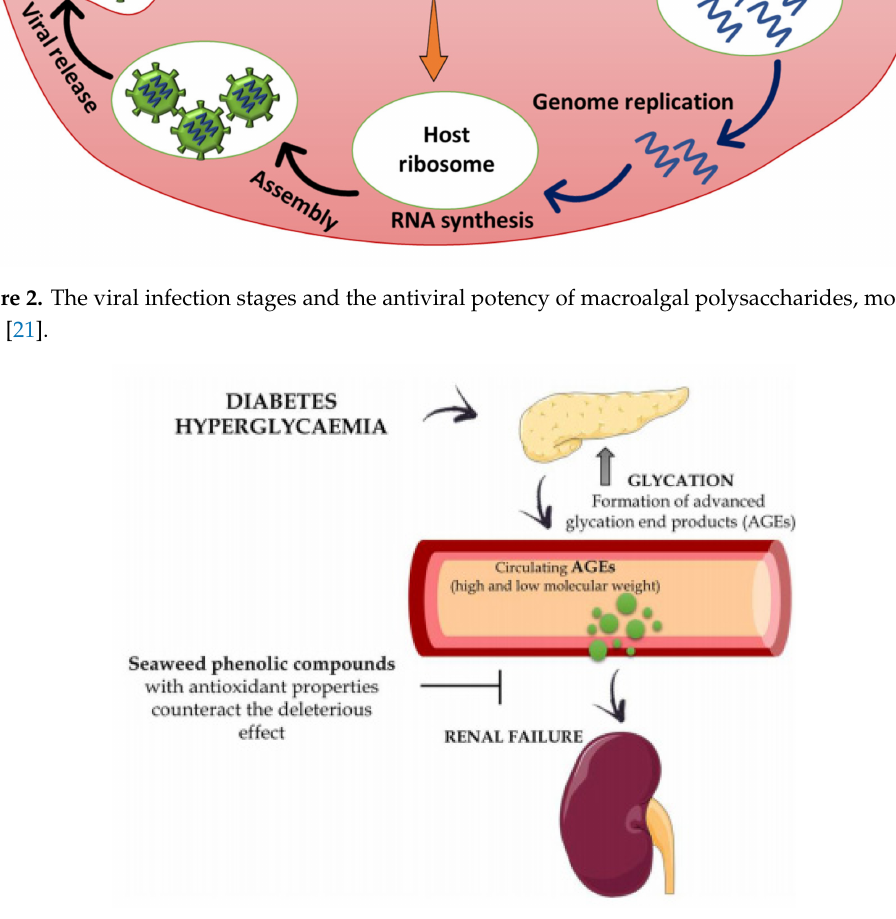
Figure 3. Graphical illustrating the antioxidant activities of macroalgal phenolic compounds toward the harmful impacts related to the hyperglycemia